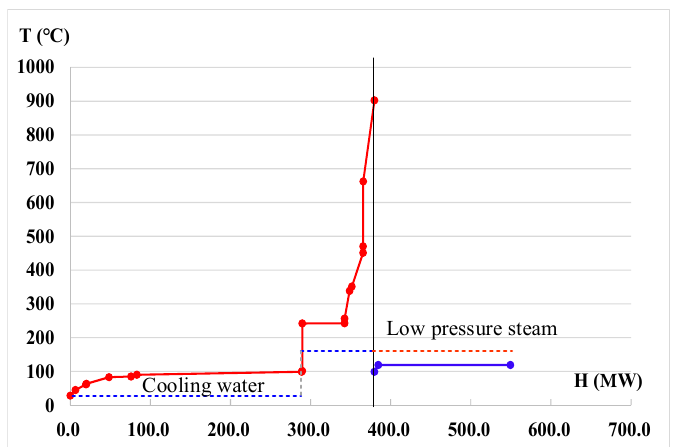
Figure 7. Total site profile for the system. (Note: red solid line represents heat source profile; blue solid line represents heat sink profile; red dashed line represents utility consumption curve; blue dashed line represents utility generation curve.)